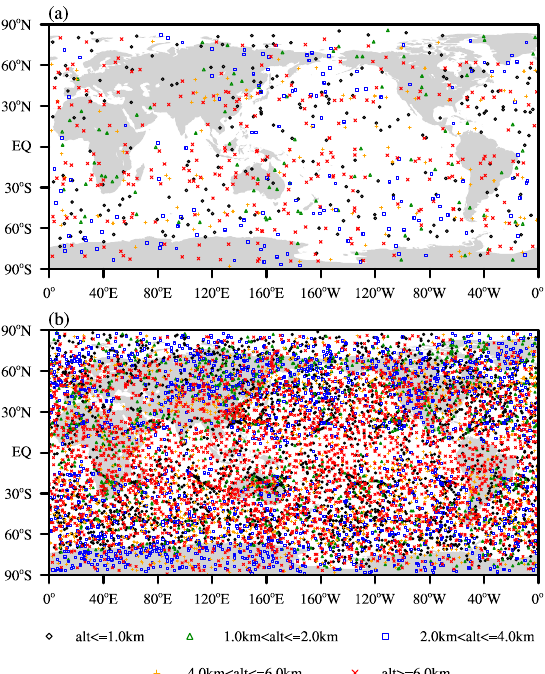
Figure 1. The characteristics of the spatial distribution for the BH RO observation location. ( a ) BH RO data on 20220208, ( b ) same as ( a ) but for the period of 8 February 2022 to 17 February 2022.